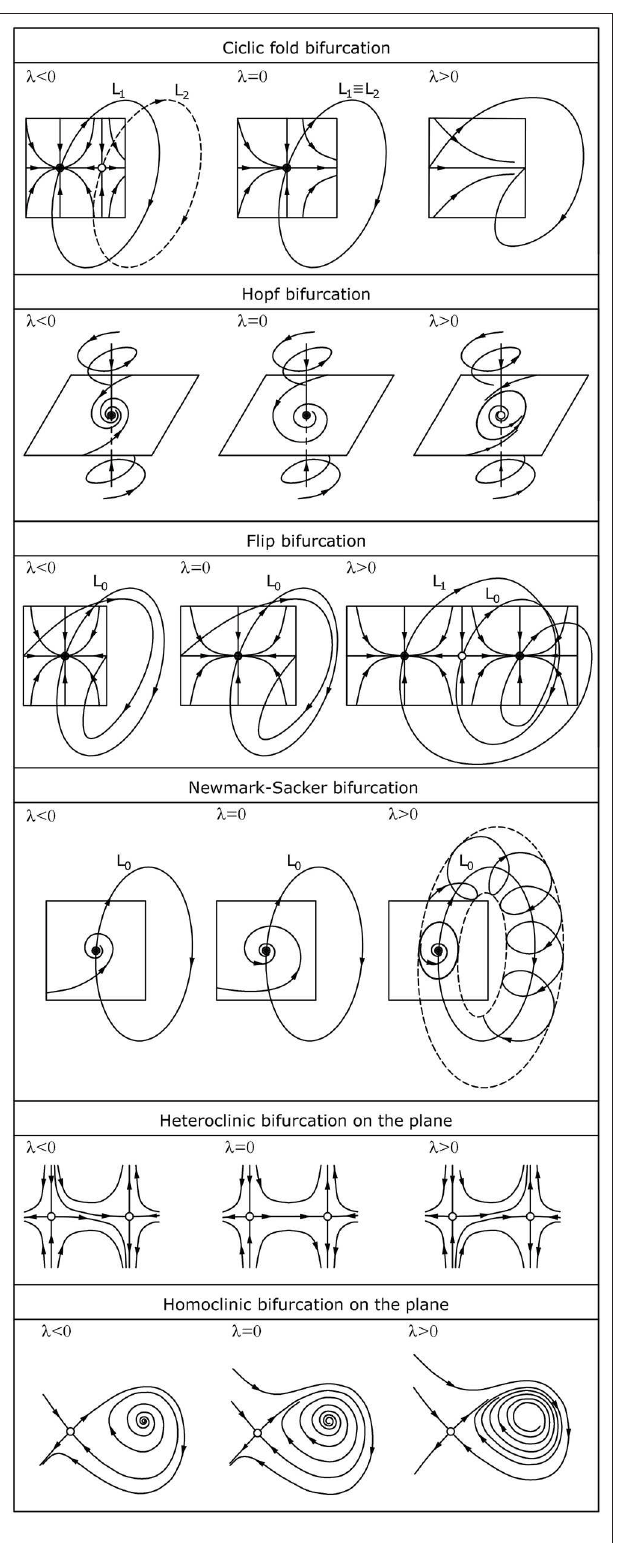
FIGURE 5 | Phase portrait evolution by changing the parameter λ of local and global dynamic